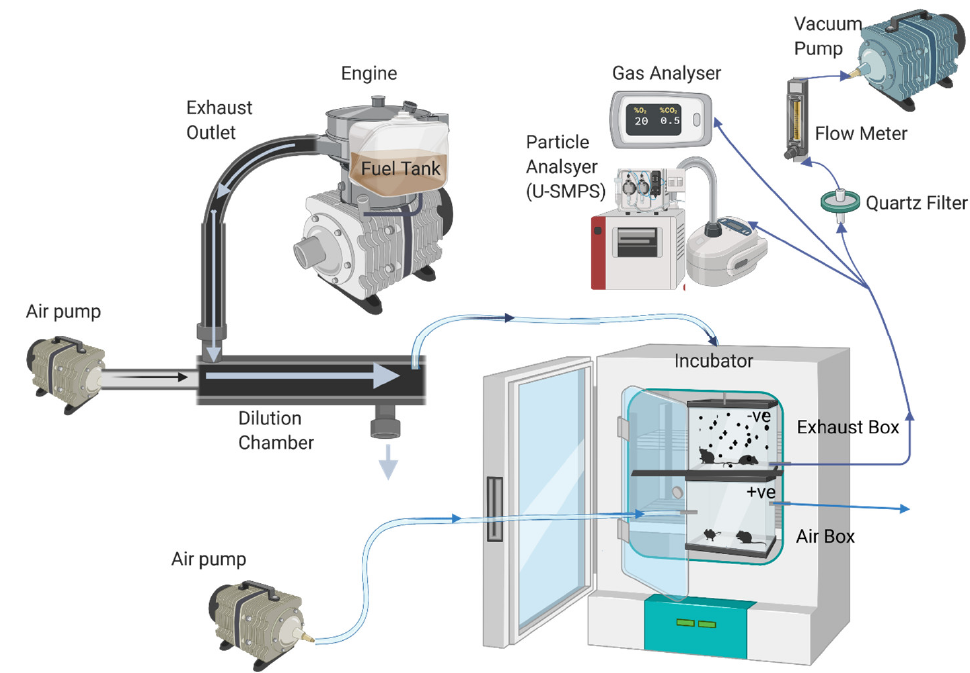
Figure 10. Diagram of exposure setup. As a vacuum is used to transport exhaust into the exhaust chamber and a pump is used to transport air into the Air chamber, a slight variation in pressure gradient was created to ensure there was no chance for cross-exposure of groups. Created with Biorender.com.